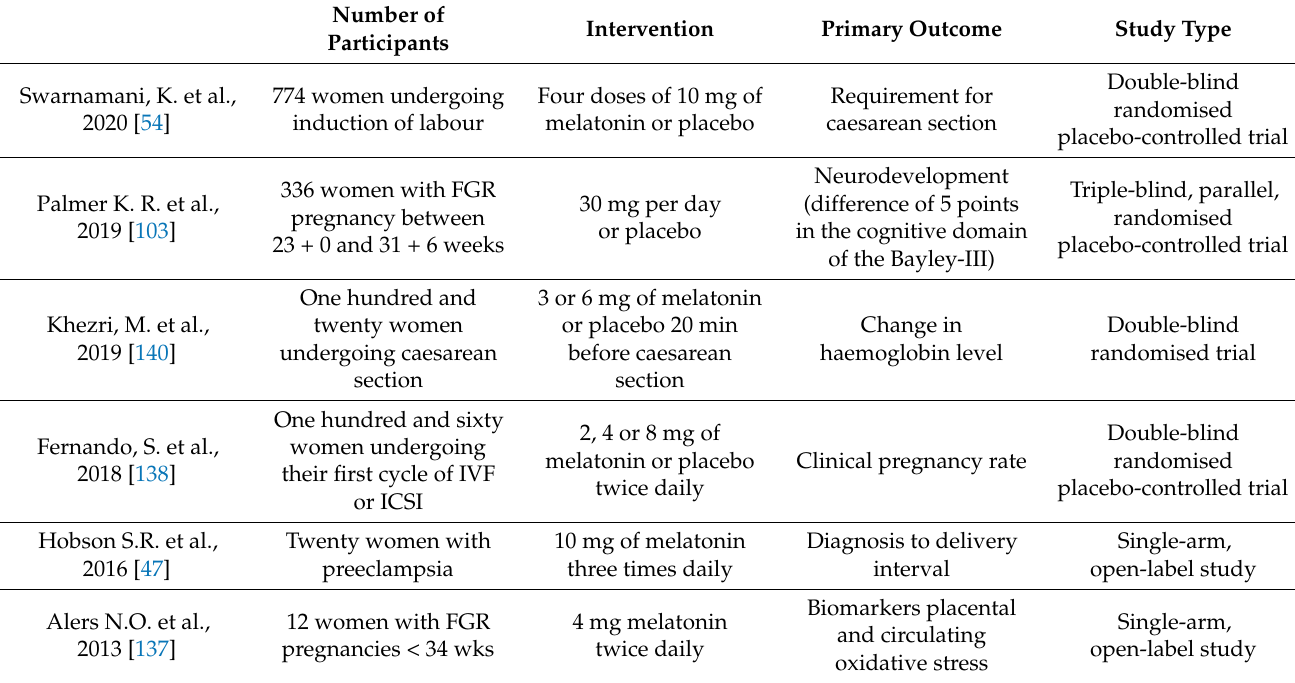
Table 1. Summary of clinical trials investigating melatonin for pregnancy